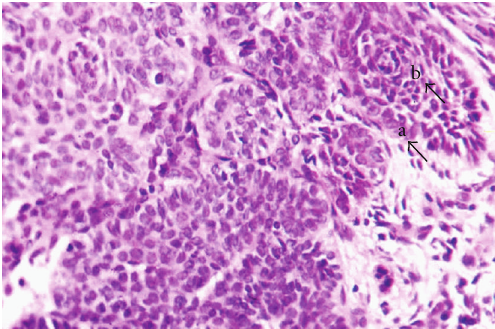
Figure 3: Ameloblastomatous island of odontogenic epithelium with columnar basal cells (a) enclosing stellate reticulum like cells (b) [Hemataoxylin and Eosin, × 40].